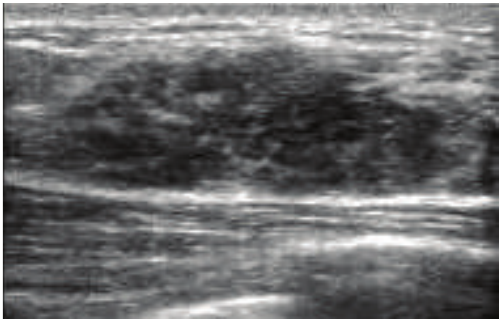
Figure 2: Ultrasonography showed a heterogeneous hypoechoic mass with an ill-defined margin, measuring 3.4 × 1.1 × 3.0cm.